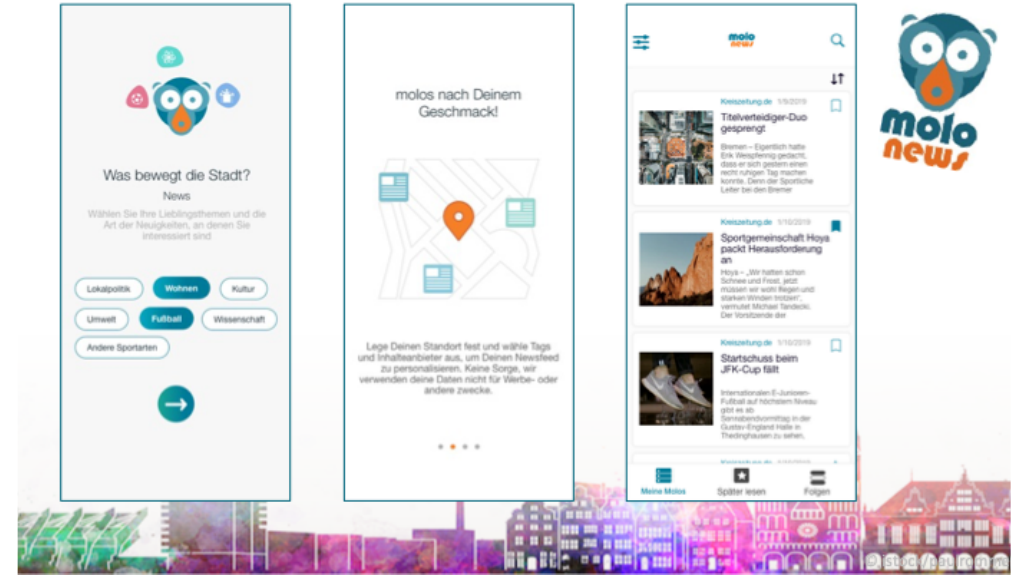
Figure 3. The molo.news